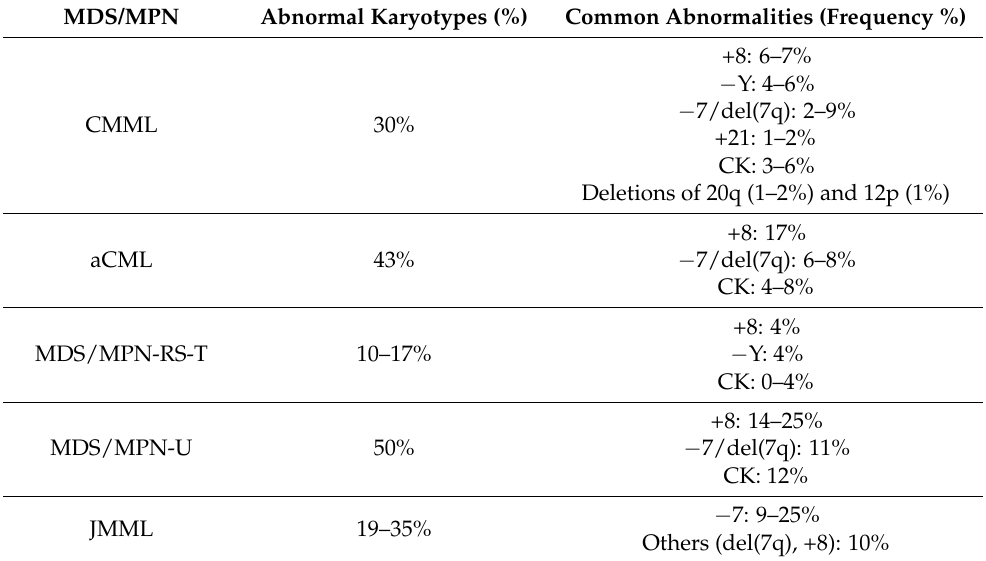
Table 1. Cytogenetic abnormalities in